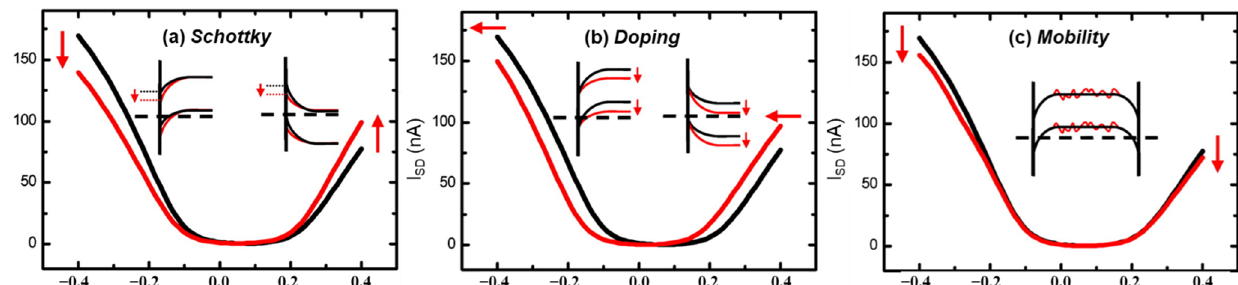
Figure 5. Hypothetical transfer (I SD − V G ) curves before (black) and after (red) gas adsorption for three different sensing mechanisms. Insets illustrate the corresponding changes in the band diagrams: ( a ) Schottky barrier modulation corresponds to a change of barrier height, the work function difference between metal and SWCNT; ( b ) N-doping of the CNT induces a shift of the I − V curve to more negative voltages; ( c ) Change in Mobility induced by factors that reduce the conductivity, such as the addition of resistive elements or carrier scattering. Adapted with permission from Ref. [47]. Copyright 2008, American Chemical Society.